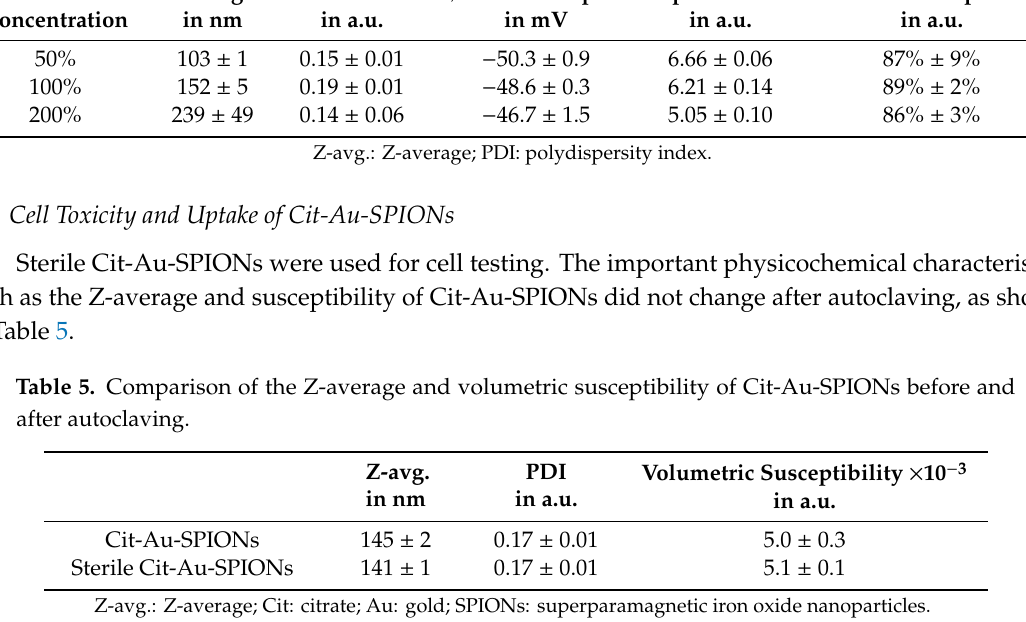
Table 4. Comparison of the basic parameters of Cit-Au-SPIONs with varied gold concentrations. Gold Z-Avg. PDI Concentration in nm in a.u. in a.u. in a.u.